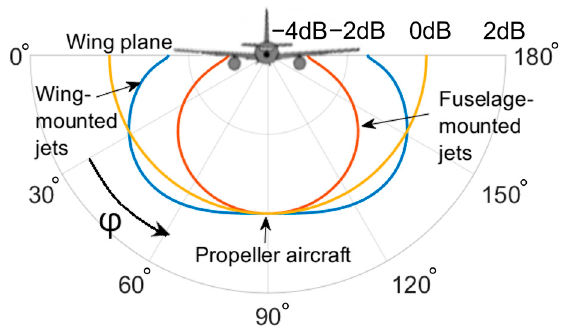
Figure 2. Engine installation effects on aircraft noise directivity. Noise level correction (dB) as a function of depression angle (deg).